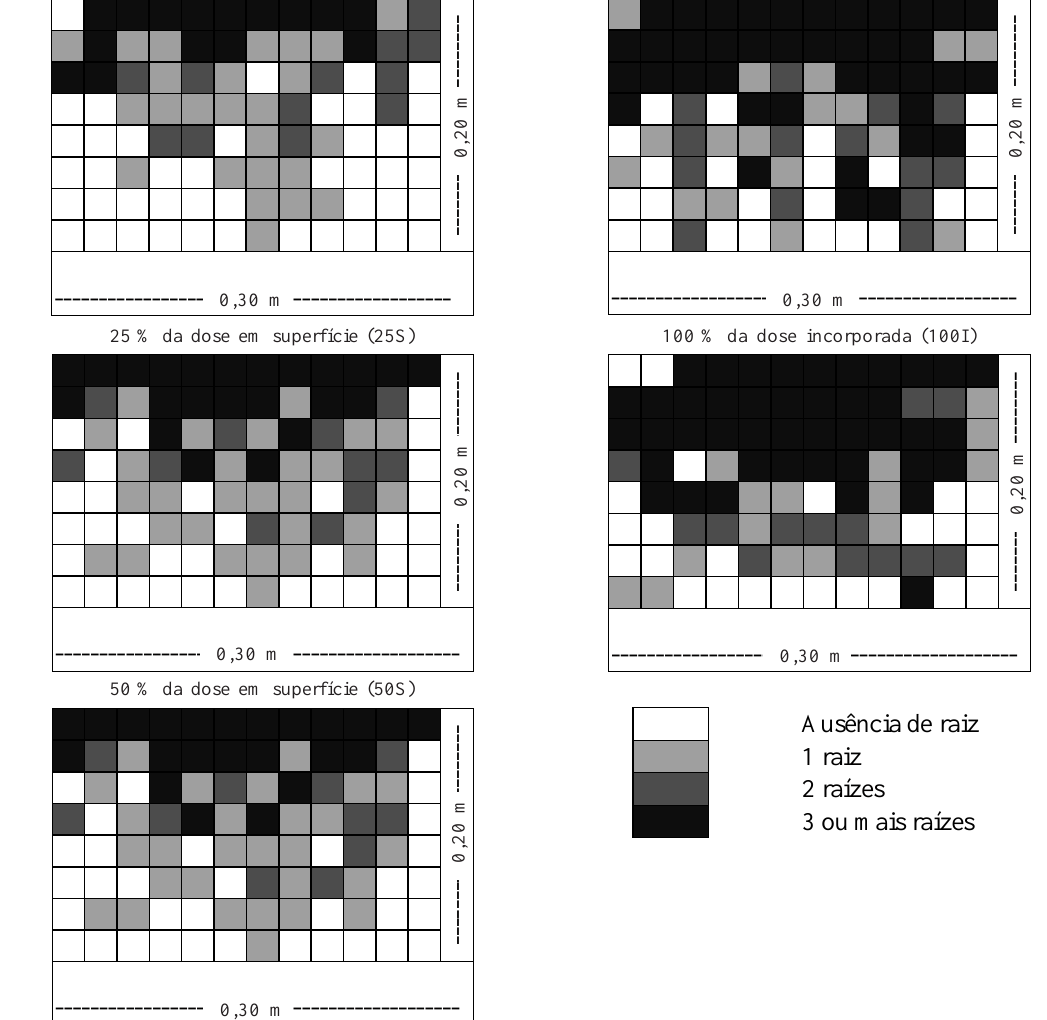
Figura 5. Perfil de enraizamento da cultura do milho aos 20 dias da emergência no Argissolo Vermelho distrófico arênico sob semeadura